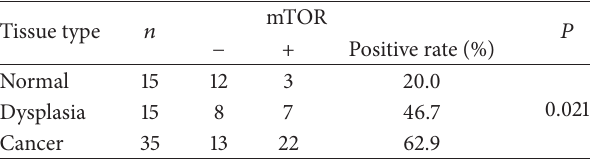
Table 1: Expressions of mTOR proteins in different